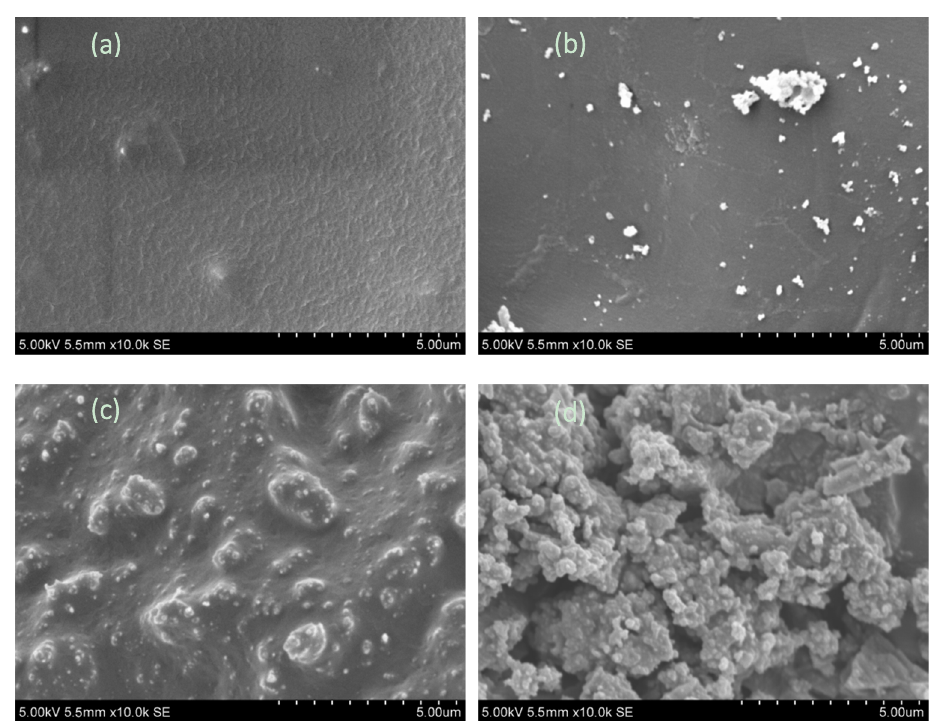
Figure 5. Scanning electron microscopy (SEM) images of chars prepared from ( a ) pure lignin pyrolysis or with the additions of ( b ) CaCl 2 , ( c ) Ca(OH) 2 , and ( d ) Ca(HCOO) 2 .